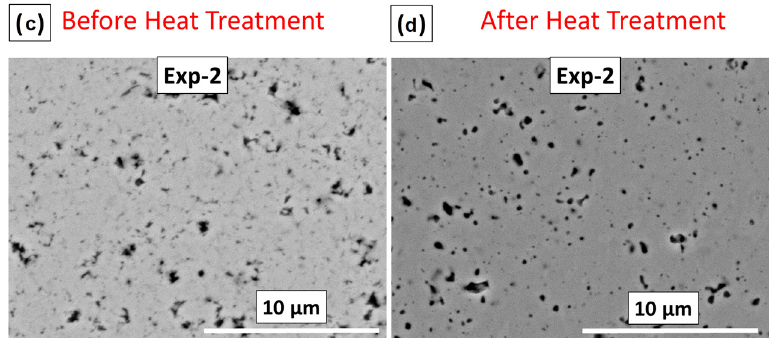
Figure 7. SEM micrograph of the cross-section of coating Exp-4 ( a,b ) at high magnification showing the fine porosity before ( a,c ) and after ( b,d ) heat treatment and hint of coalescence and densification of pores is also shown. In addition, similar micrograph of coating Exp-2 ( c,d ) showing no as significant change as in coating Exp-4 in the fine porosity.